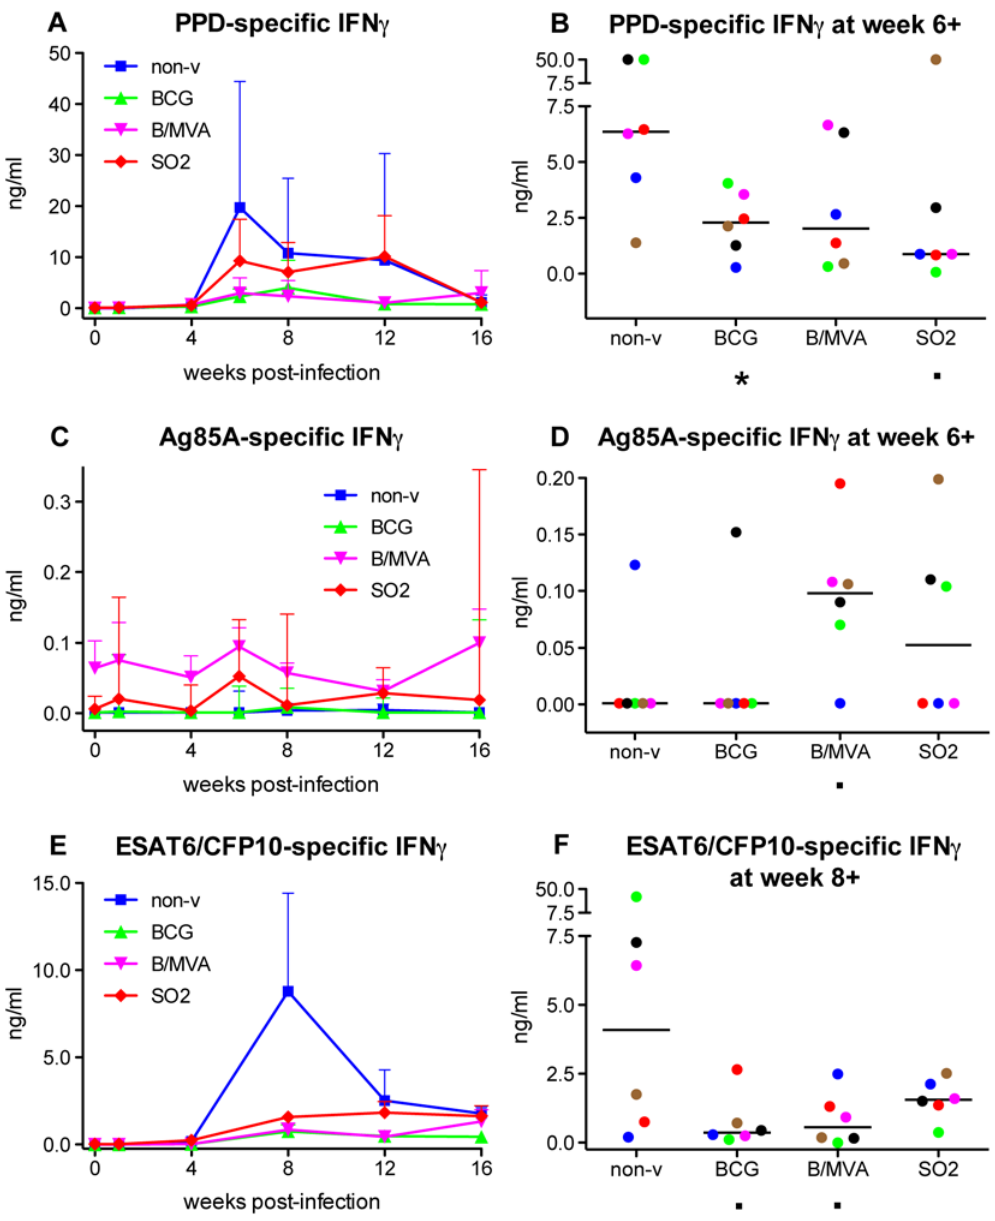
Figure 6. Mycobacterium-specific IFN c secretion post-infection. Both PPD and ESAT6-CFP10 fusion protein, but not Ag85A, induce relatively high levels of IFN c from in vitro stimulated fresh PBMC after infectious challenge with M. tuberculosis . Treatment group means ( + standard errors) are plotted in time for PPD (A), Ag85A (C) and ESAT6/CFP10 fusion protein (E), and as individual responses (with group medians) at the peak of the mean response as indicated (B, D and F, respectively). For legends of colouring and symbols see legend to Figure 2.